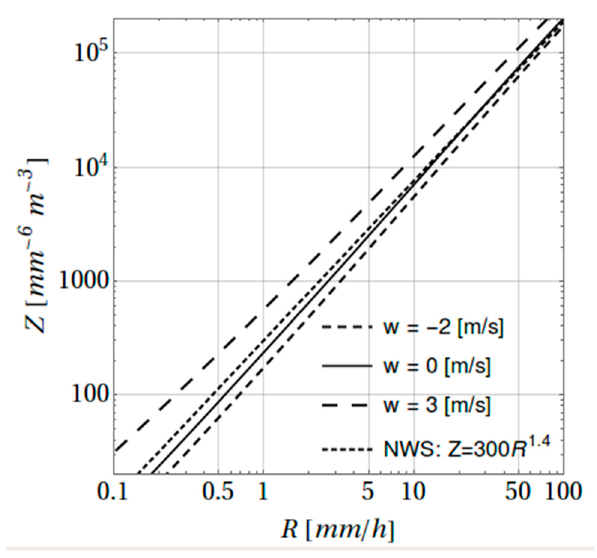
Figure 7. Z - R curves generated by FCM-DSD model with N 0 = 8000 (mm − 1 m − 3 ), β = 1, and w 0 =